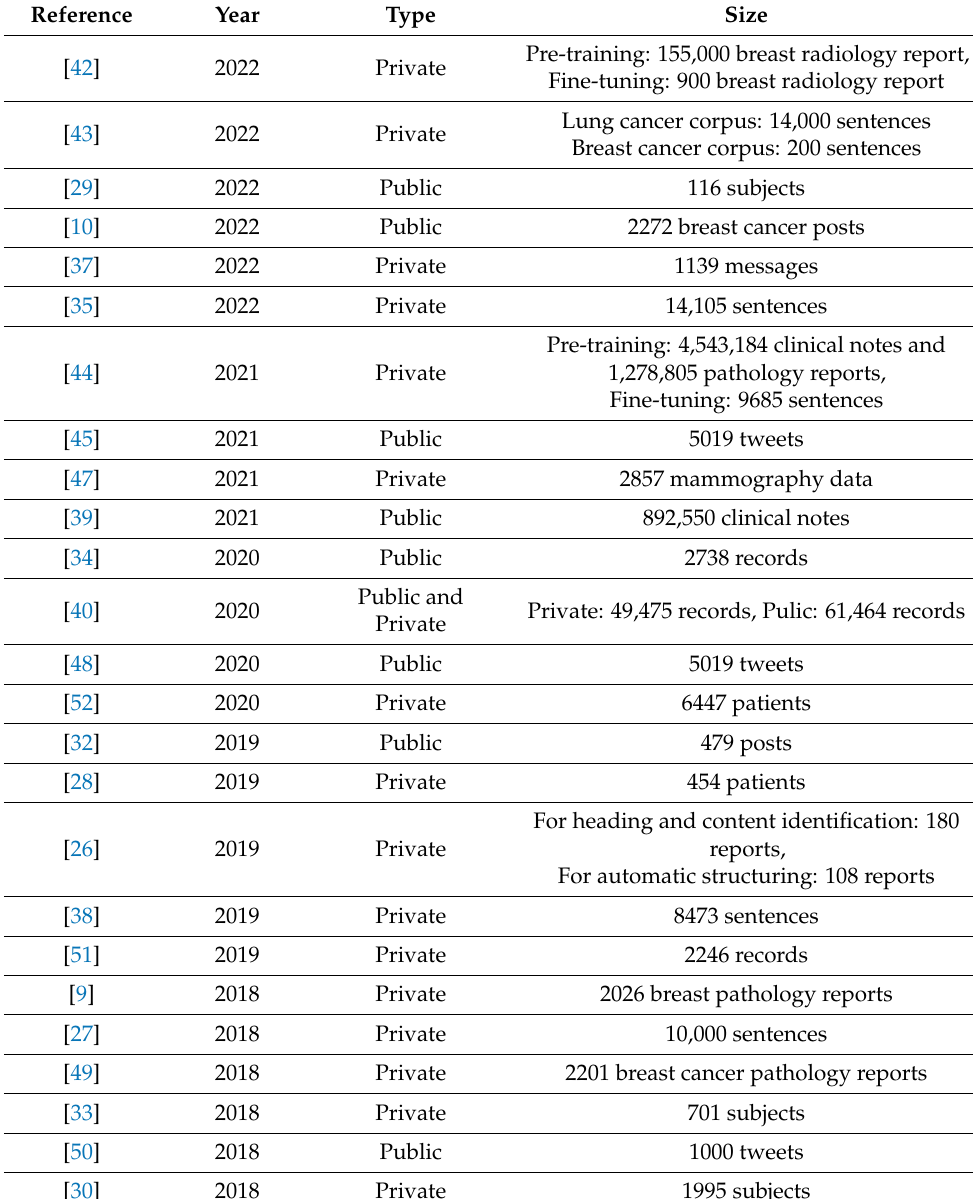
Public represents the dataset is